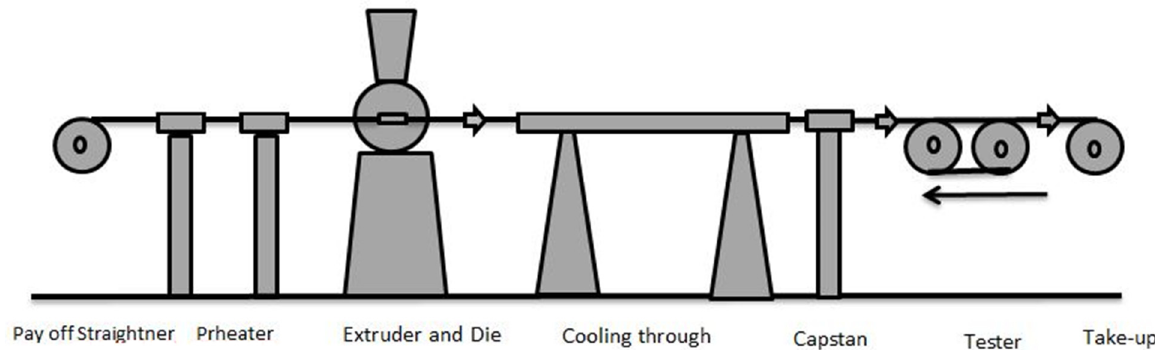
Figure 1. A typical wire-coating process.